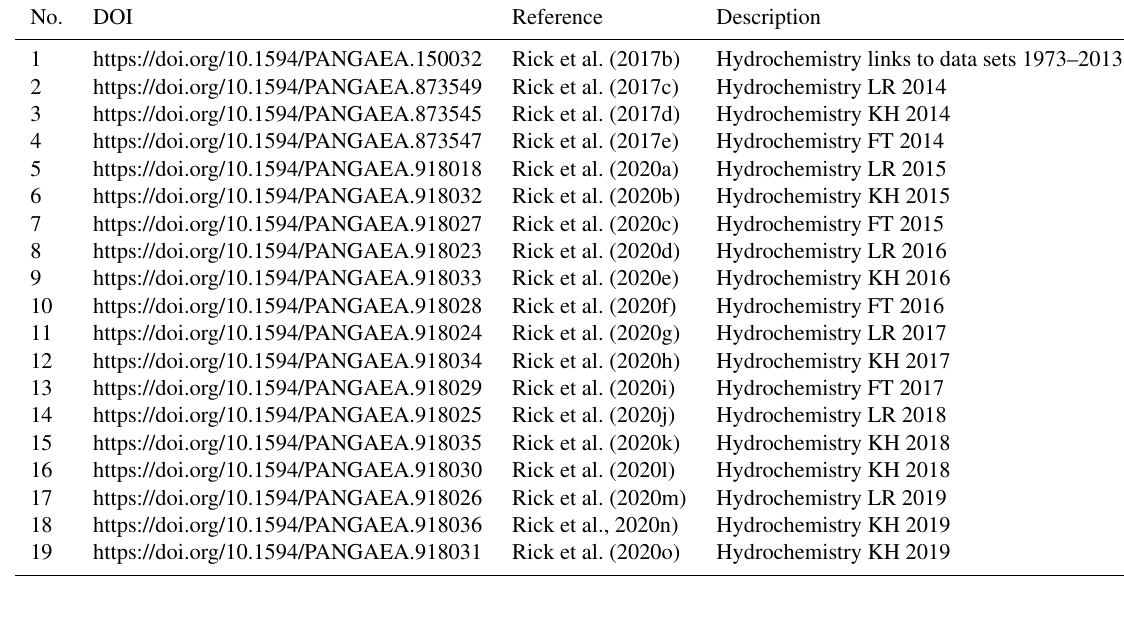
Table 5. Data access table. Descriptions of the data (LR – List Reede or List Roads station; KH – Königshafen station; FT – ferry terminal station) are given, along with the respective DOI and the abbreviation of the data publication used in the text.